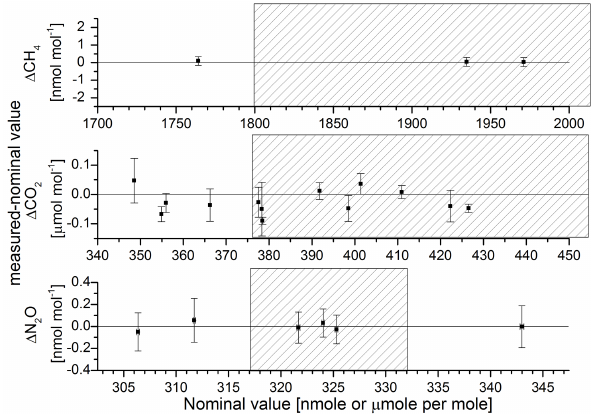
Figure 1. Difference between TCI-measured Heidelberg WMO CCL tertiary standards and their respective nominal value given by WMO CCL (TCI-measured – WMO CCL nominal value). The measurements were performed on 30 May 2013, 24 June 2013, 3 July 2013, 2 September 2013 and 3 September 2013. The standard deviation plotted combines the standard error of the repeated cylin- der measurements and the error of the nominal WMO CCL tertiary cylinder value. Shaded areas indicate the calibrated TCI mole frac- tion